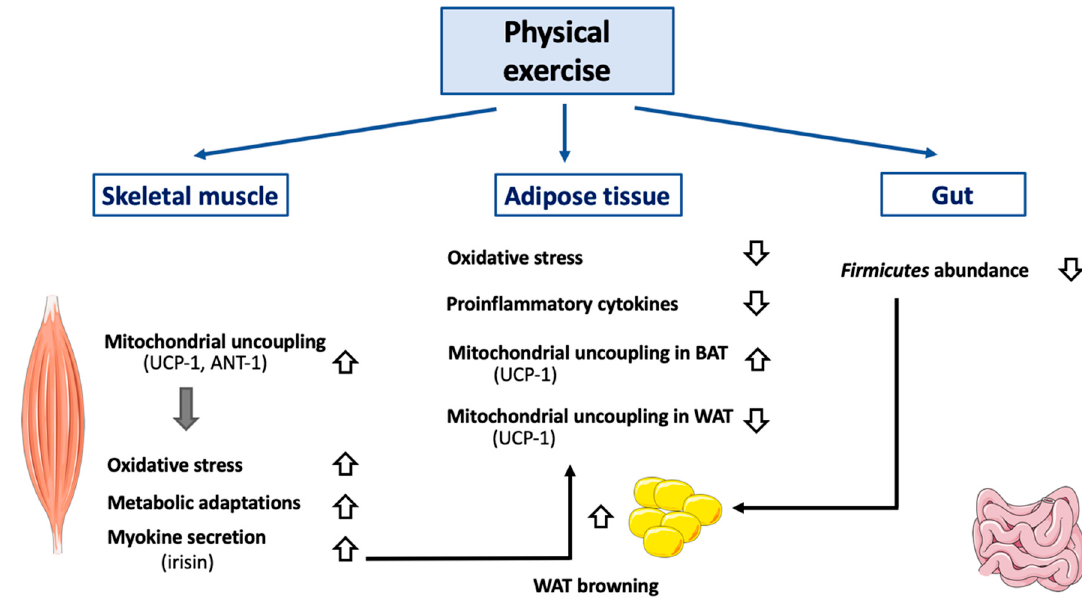
Figure 3. E ff ect of exercise on mitochondrial uncoupling and peripheral organs. Abbreviations: ANT-1 (Adenine Nucletotide Transferase-1), BAT (Brown Adipose Tissue), UCP-1 (Uncoupling Protein-1), WAT (White Adipose Tissue). Di ff erent kinds of physical exercise (acute and chronic) trigger mitochondrial uncoupling in skeletal muscle, by activating and by increasing both UCP-1 and ANT-1 expression. Of note, molecular mechanisms triggered di ff er according to the species considered and are not yet entirely defined. Activation of mitochondrial uncoupling in skeletal muscle also reduces oxidative stress and induces mitochondrial adaptations (including increase in mitochondrial mass, increase in respiratory chain component abundance). Physical exercise also has an impact on adipose tissues. In BAT, mitochondrial uncoupling will be activated (UCP-1 dependent), while it will be attenuated in WAT. Browning of WAT will also be induced, an e ff ect dependent, at least partially, on irisin secretion by skeletal muscle. An association between decreased Firmicutes level in gastrointestinal tract (associated